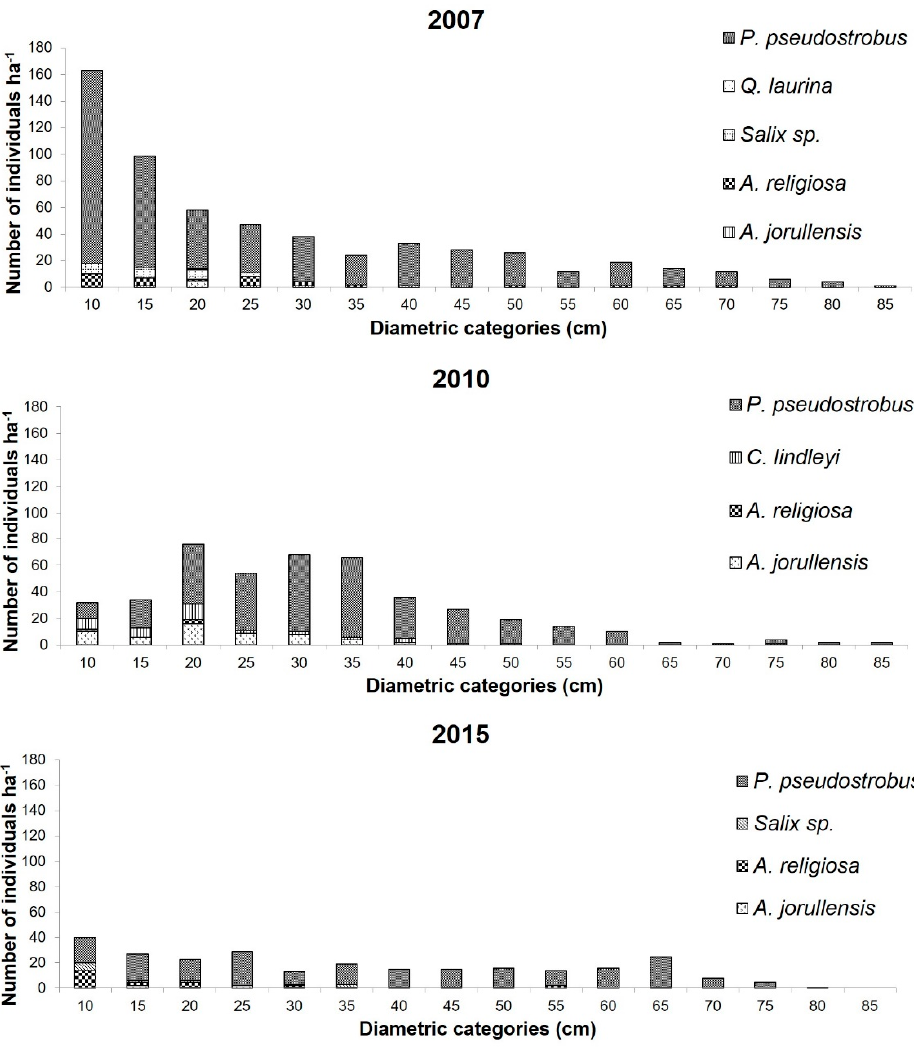
Figure 4. Horizontal structure characterized by diameter distribution in three years of harvesting (Ejido de Palo Seco, Coatepec Harinas). Table 3. Harvesting intensity by species and diameter class.